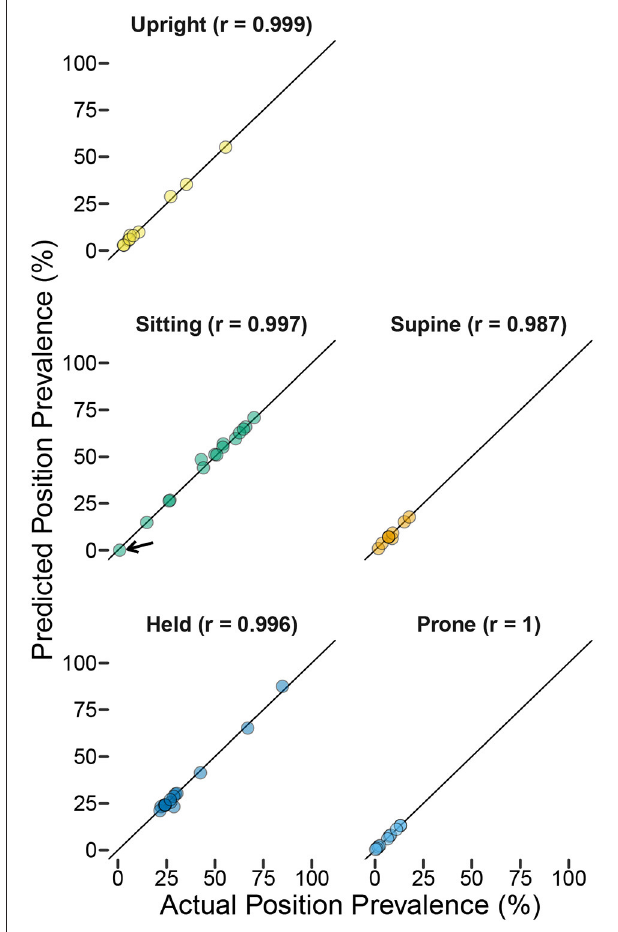
FIGURE 5 | Predicted position prevalence from classification ( y -axis) plotted against actual position prevalence from human coding of body position ( x -axis) in the laboratory study. Each graph shows one body position (colors indicate body position), and each symbol represents one participant (titles indicate the r -value for the correlation between actual and predicted within each position category). The black arrow in the sitting figure shows the outlier participant with the worst sensitivity from Figure 3